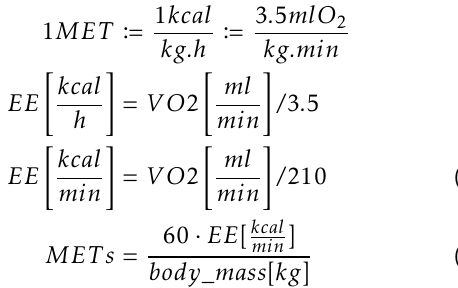
Figure 3. Example of one of the tests in the protocol